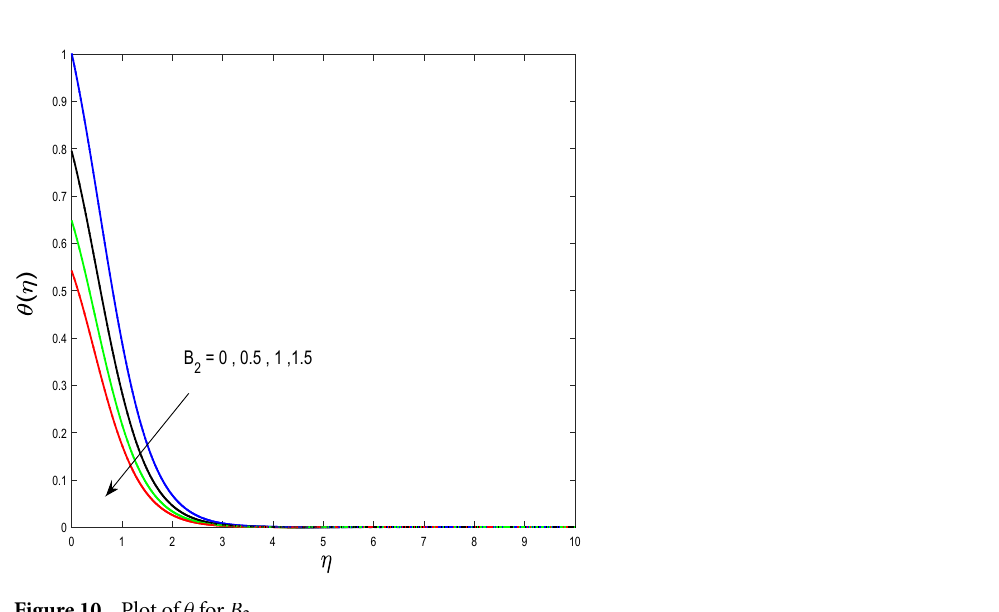
Figure 10. Plot of θ for B 2